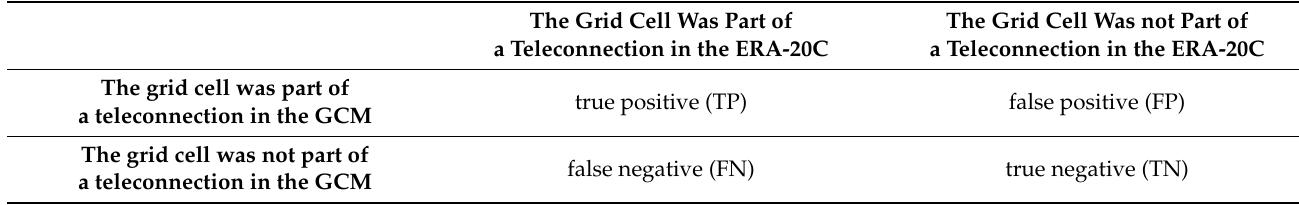
Table 2. Contingency table of the ROC curve analysis.